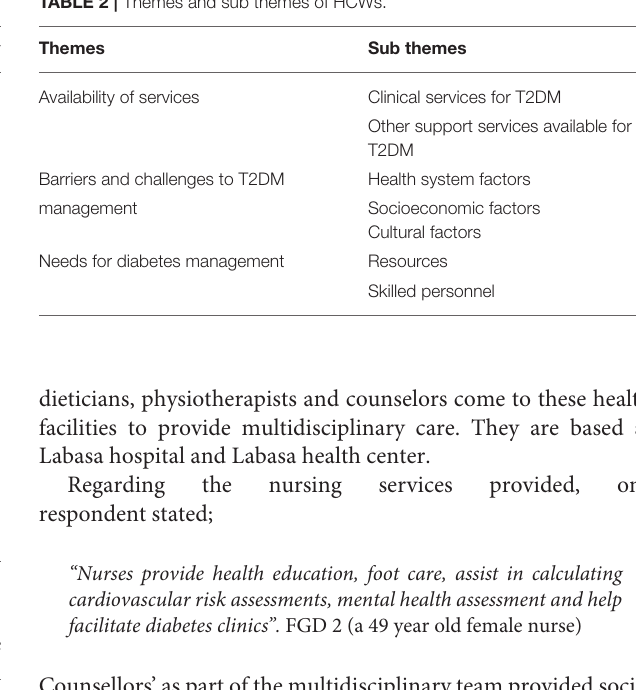
TABLE 2 | Themes and sub themes of